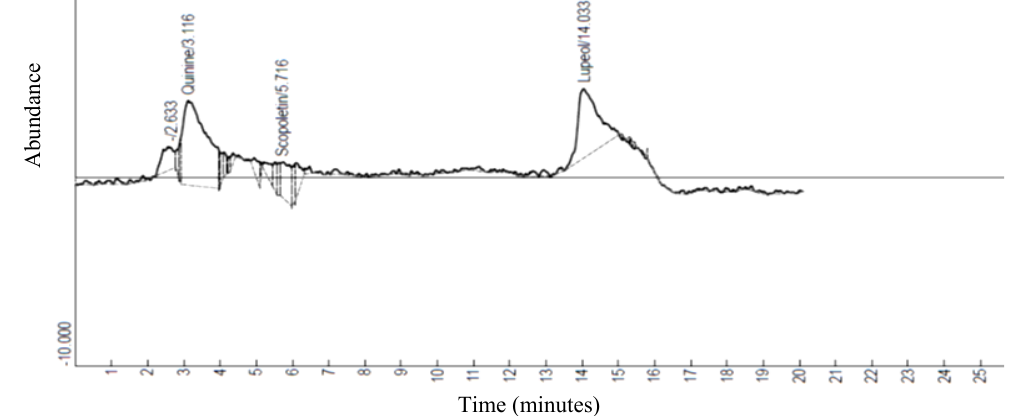
Fig. 3. A chromatogram of Alkaloids in fractionated Leptadenia Hastata extract